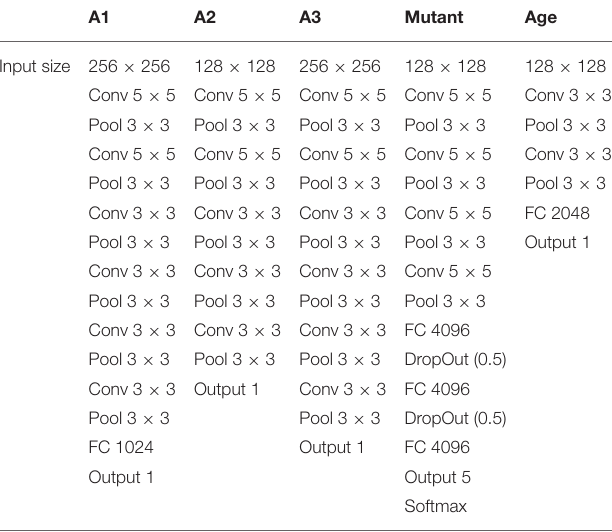
TABLE 1 | The network architectures used for each of the phenotyping datasets and tasks. A1